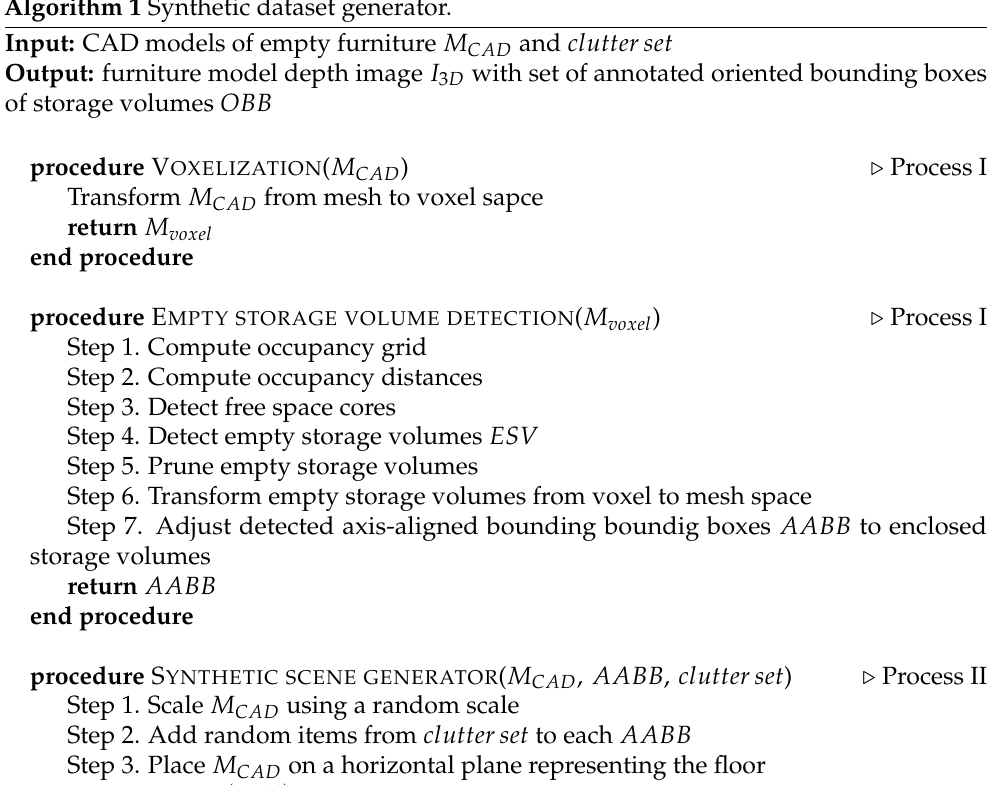
Algorithm 1 Synthetic dataset